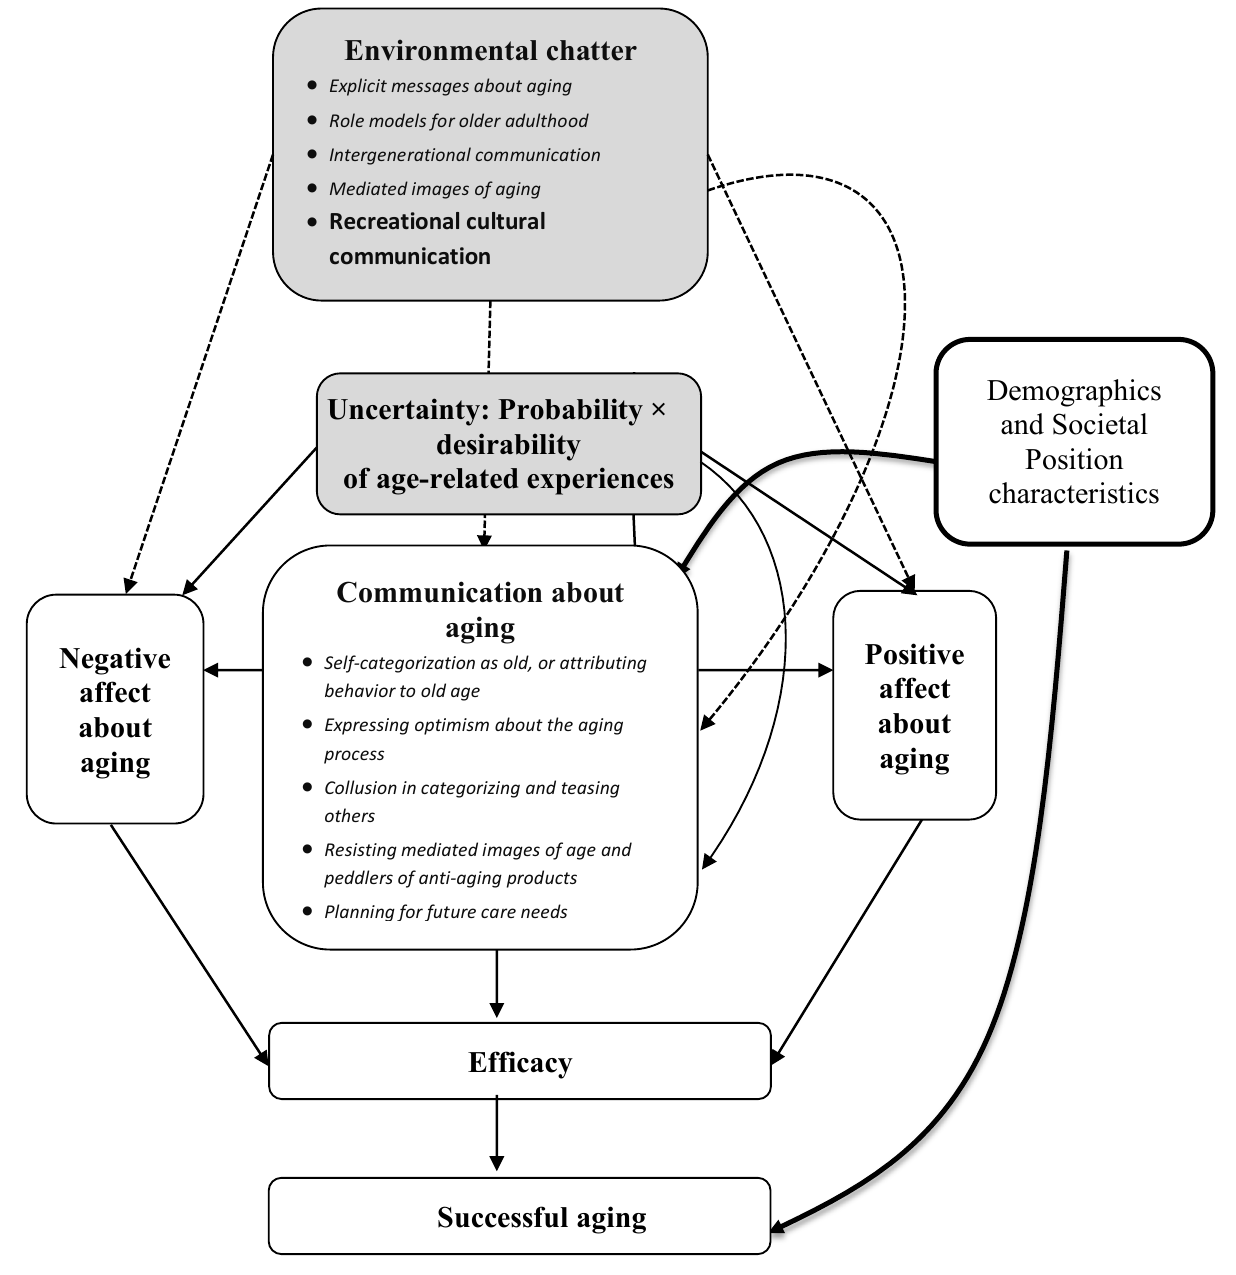
Figure 1. The revised communicative ecology model of successful aging (after Gasiorek et al. 2016) , with shaded boxes and dashed lines representing revised elements of this model over the original. Based on the current study, we inserted a fourth and non-italicized bolded component to the Environmental Chatter box